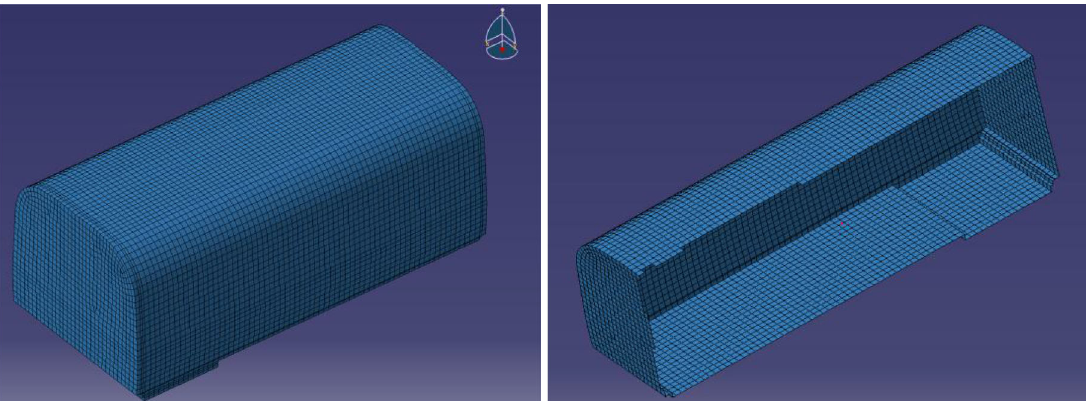
Fig. 10 Boundary of vehicle acoustic model after meshing